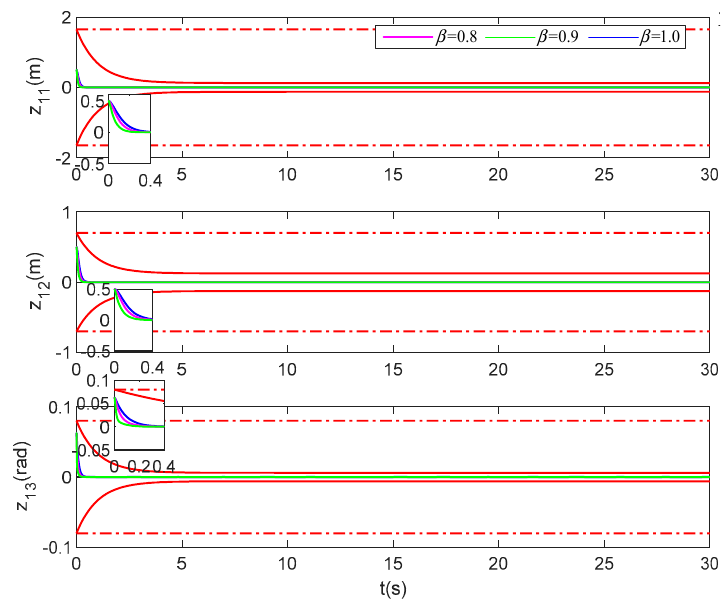
Figure 13. Pose tracking error of the vessel with different orders.